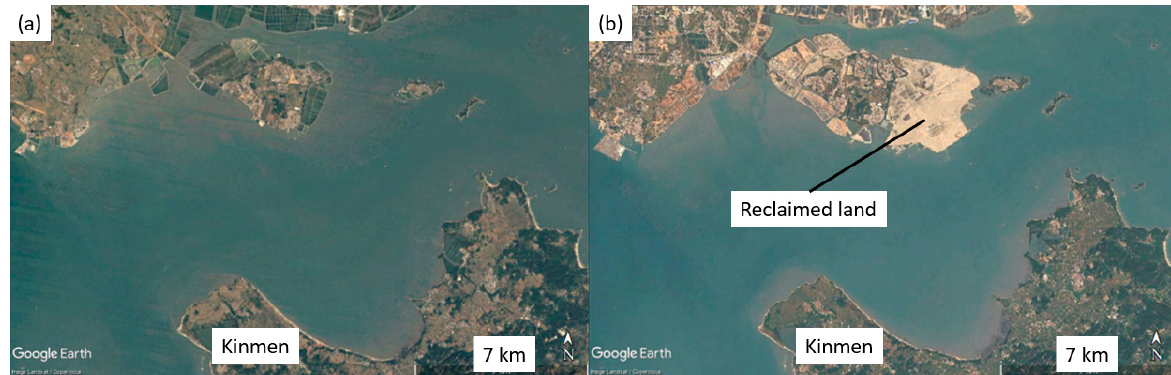
Figure 3. Progress of the land reclamation project between ( a ) December 2010 and ( b ) December 2020 [20].